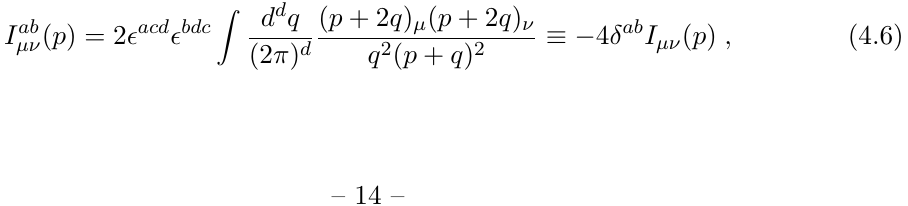
Figure 2 . Two-loop diagrams without external gauge field insertions: a) I 1 . b) I 2 . c) I 0 I 4 . f) I 5 . g) I 6